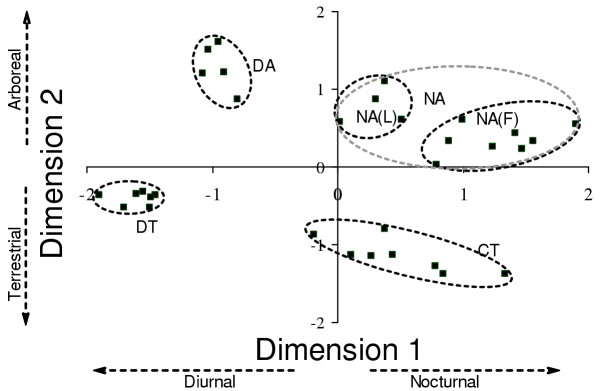
NMDS configuration showing ecological groups (EGs) of frogs and lizards in the assemblage. Each point represents a species. For this configuration, stress = 0.14712 and RSQ =.90076 [17]. Broad characteristics of EGs are as follows: DA= Diurnal, arboreal; NA(L)= Nocturnal, arboreal, all lizards; NA(F)= Nocturnal, arboreal, all frogs; CT= Crepuscular-nocturnal, terrestrial; DT= Diurnal, terrestrial. See Additional file 4 for EG species' identities.